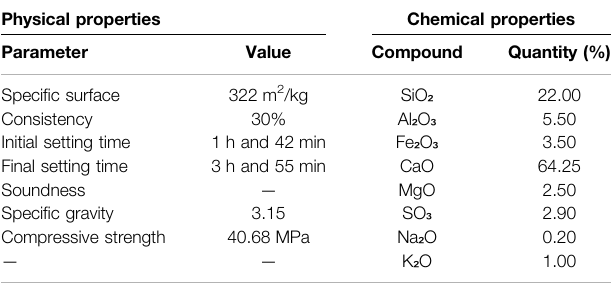
TABLE 2 | Physical and chemical properties of cement as provided by the manufacturer (Fauji cement).